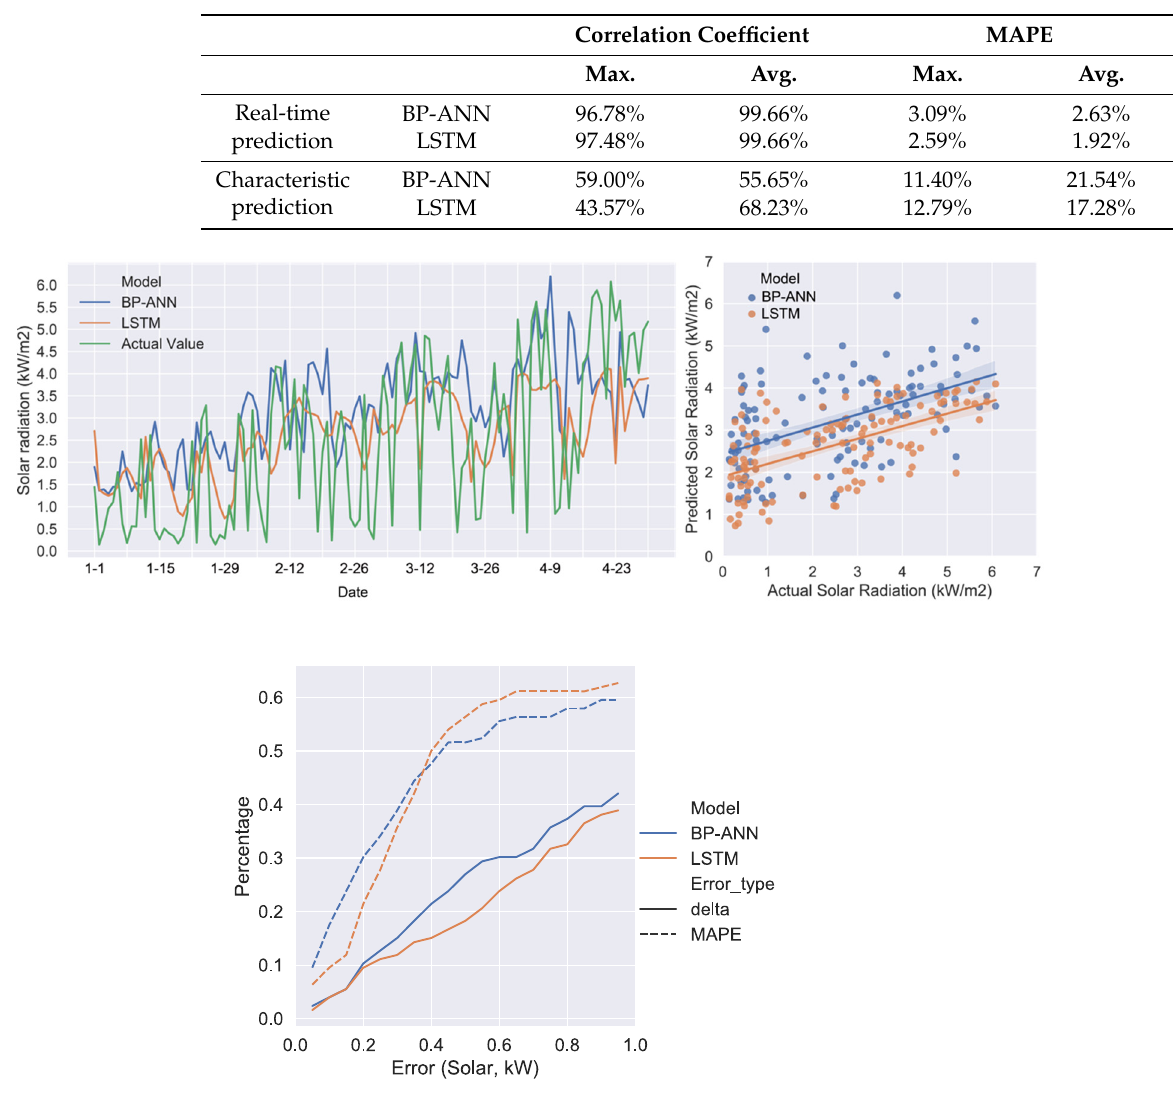
Figure 12. The prediction of total solar radiation and its x-accuracy results BP-ANN and LSTM tech- niques. Table 3. The correlation coefficient and MAPE assessment indices for daily RH prediction results of two models using BP-ANN and LSTM